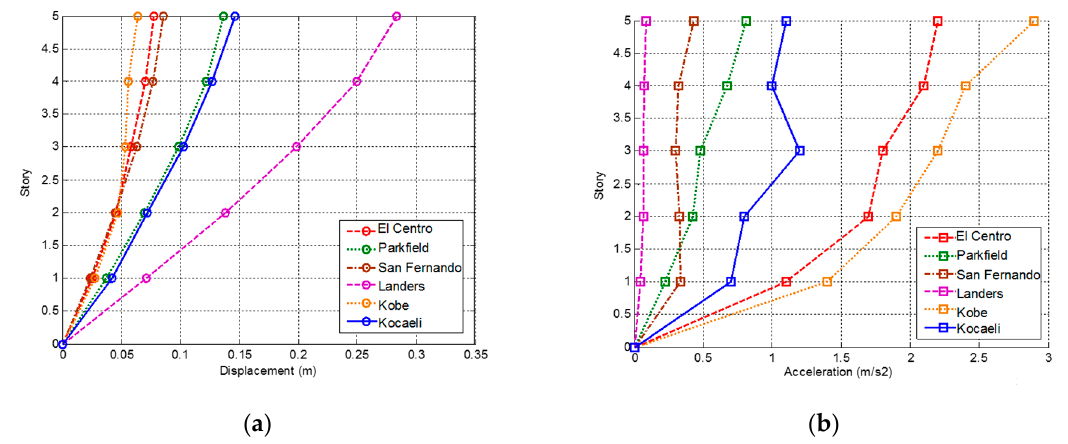
Figure 9. The results of ( a ) peak displacement and ( b ) peak acceleration for different stories of building with TMD.